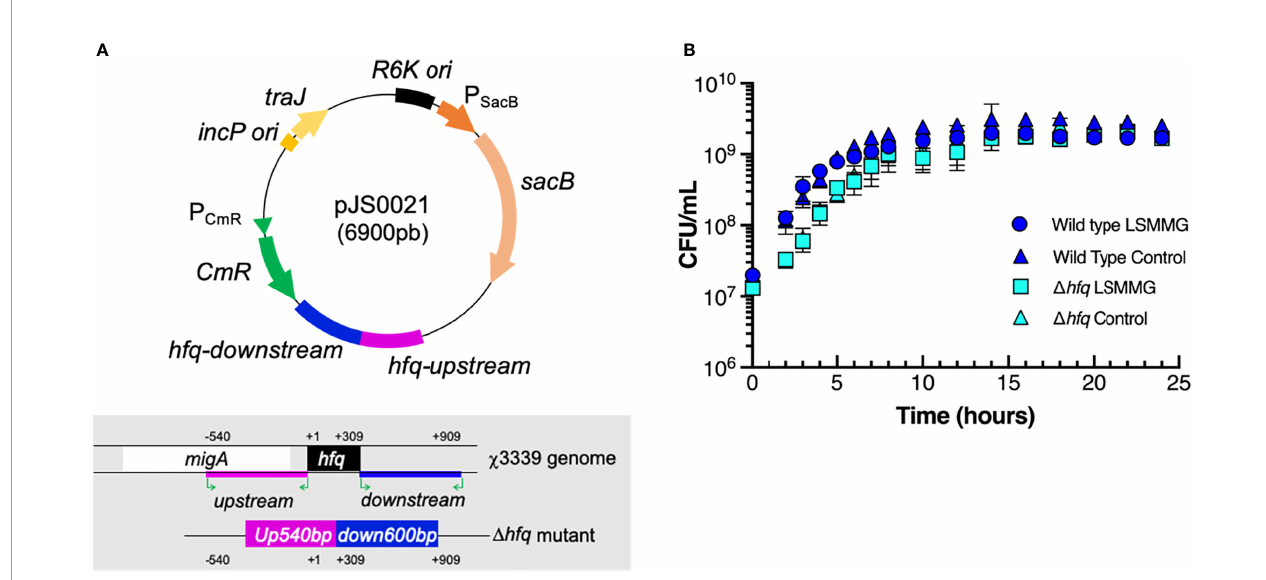
FIGURE 2 | D hfq mutant construction and bacterial growth curves. (A) Plasmid map of pJS0021 used to construct the D hfq mutant and schematic overview showing the deletion of the hfq gene in c 3339. Pink and blue regions represent the PCR-ampli fi ed 540 base pair (bp) upstream and 600 bp downstream regions of the gene that were ligated to suicide vector pRE112 to construct pJS0021, as described in the materials and methods. (B) Growth curves of wild type S . Typhimurium and the D hfq mutant in RWV bioreactors positioned in the LSMMG or control orientations. CFU/mL = colony forming units per mL. Data points and error bars represent the mean value and standard deviation, respectively, from at least three independent biological replicates each plated in technical